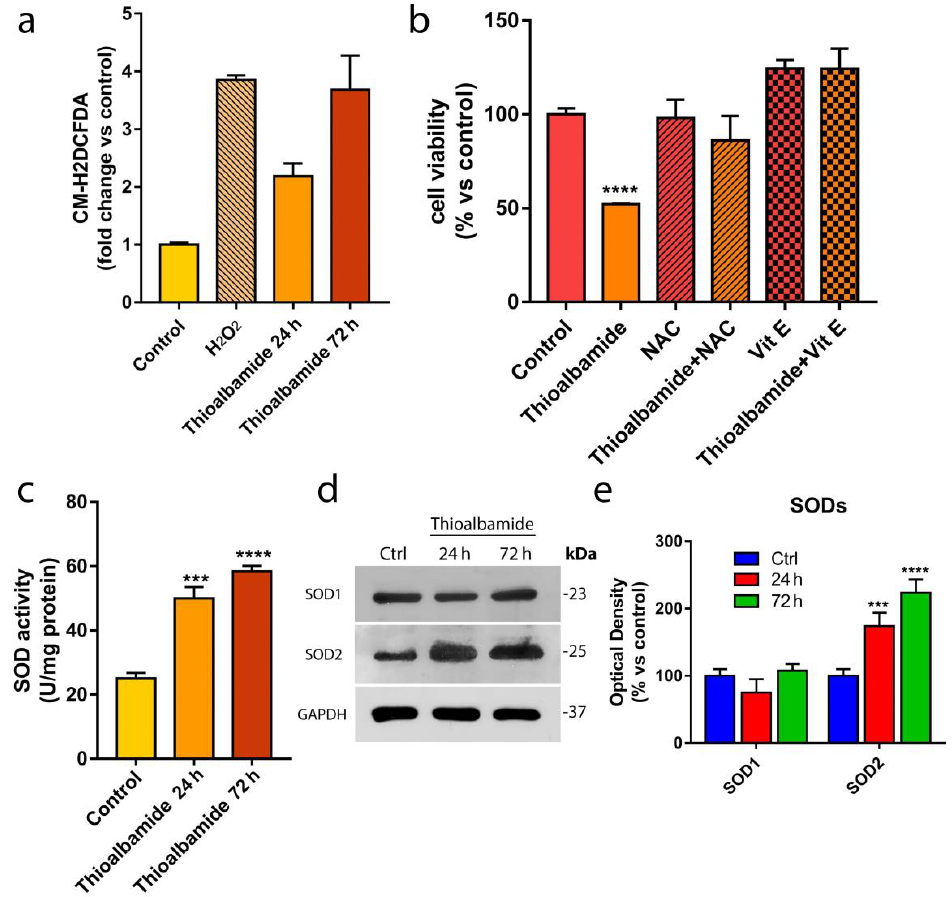
Figure 5. Oxidative stress underlies the cytotoxic effects of thioalbamide. ( a ) ROS intracellular levels were measured after thioalbamide treatment of MCF7 cells for 24 and 72 h. Results obtained from cells treated for 6 h with 1 mM H 2 O 2 , which was used as the positive control, were related to their own control. ( b ) MCF7 cell viability was assessed after treatment for 72 h with thioalbamide alone or in combination with vitamin E (Vit E) or N-acetyl cysteine (NAC). ( c ) Total SOD activity assay was performed on MCF7 cells treated with thioalbamide for 24 and 72 h. ( d ) Immunoblot analysis of SOD1 and SOD2 expression levels in MCF7 cells treated with thioalbamide for 24 and 72 h. GAPDH was used as equal loading control. ( e ) Quantification of SOD expression levels by densitometry. Thioalbamide treatments were performed at 50 nM. Note that ROS accumulation and oxidative stress underlie the proapoptotic activity of thioalbamide. Values represent the mean ± SD of three independent experiments. *** P value < 0.001; **** P value < 0.0001.